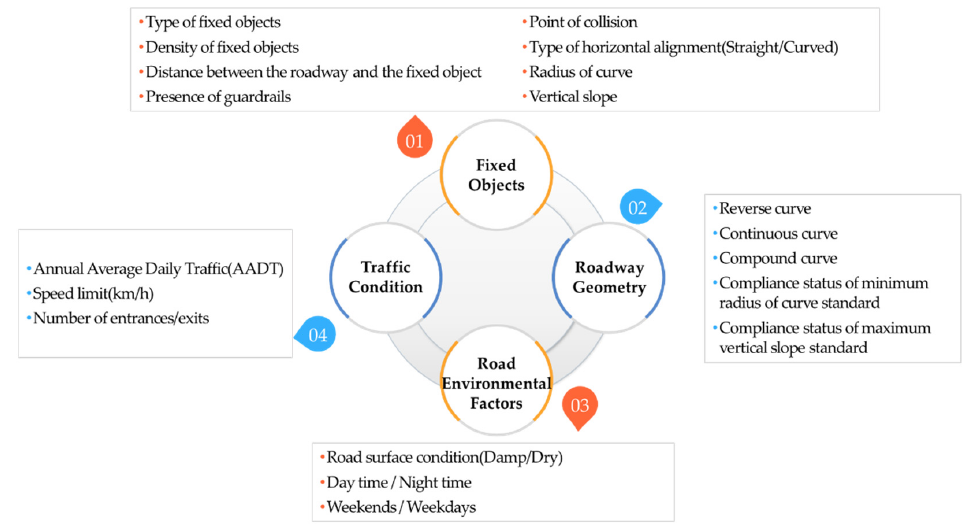
Figure 1. Categorization of independent variables by contributing factors for RORC.